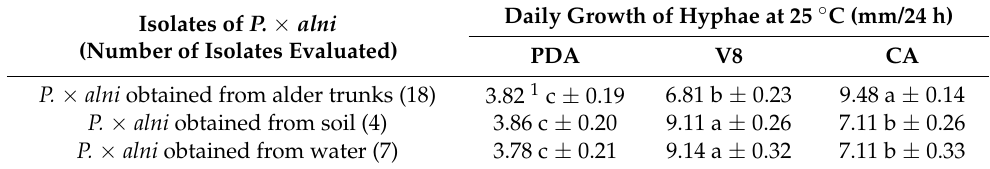
Table 2. Effect of medium on daily growth of Phytophthora × alni isolates at 25 ◦ C. Daily Growth of Hyphae at 25 ◦ C (mm/24 h) Isolates of P. × alni (Number of Isolates Evaluated) PDA V8